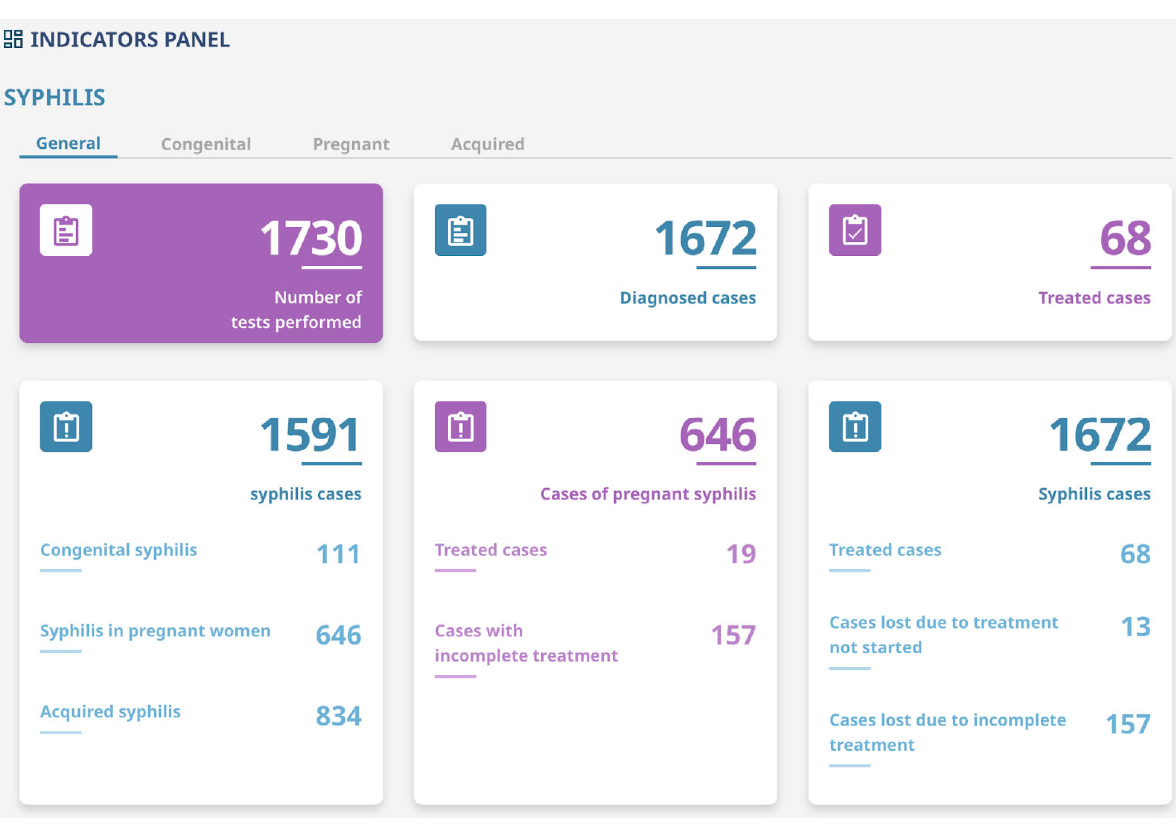
Figure A1. Case panel.